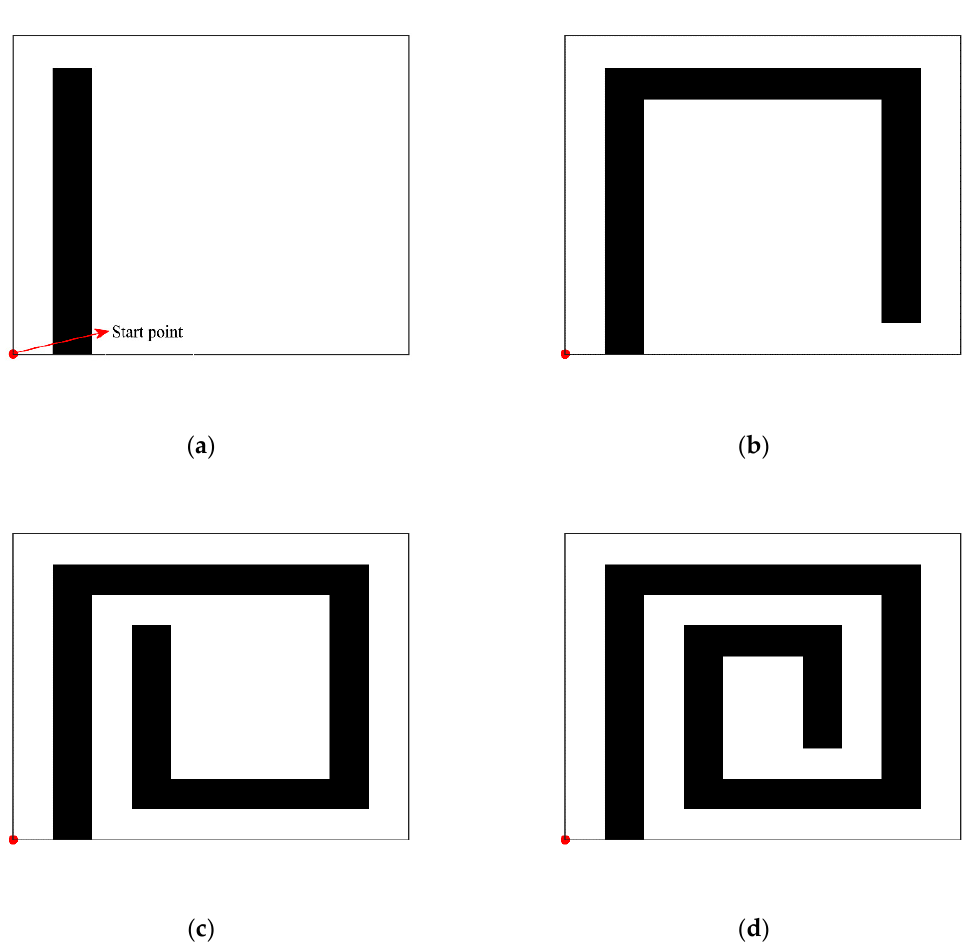
Figure 17. Some of the environments with barriers: ( a ) 1 barrier; ( b ) 3 barriers; ( c ) 5 barriers; ( d ) 7 barriers.